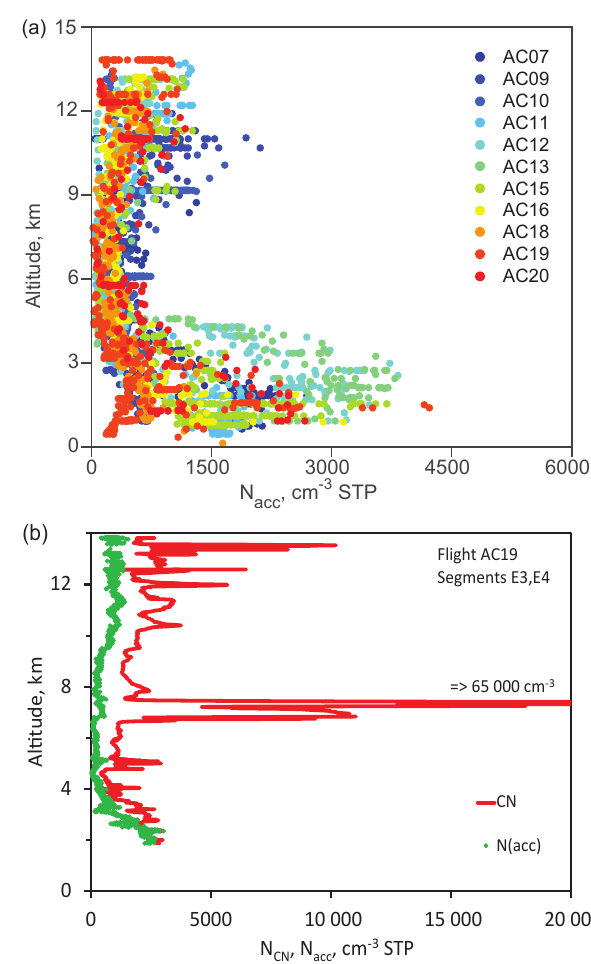
Figure 8. Vertical profiles of accumulation-mode particle concen- trations, N acc ; (a) 1min averaged data from all flights, (b) N acc profile from flight AC19 together with the profile of N CN from the same flight (1s